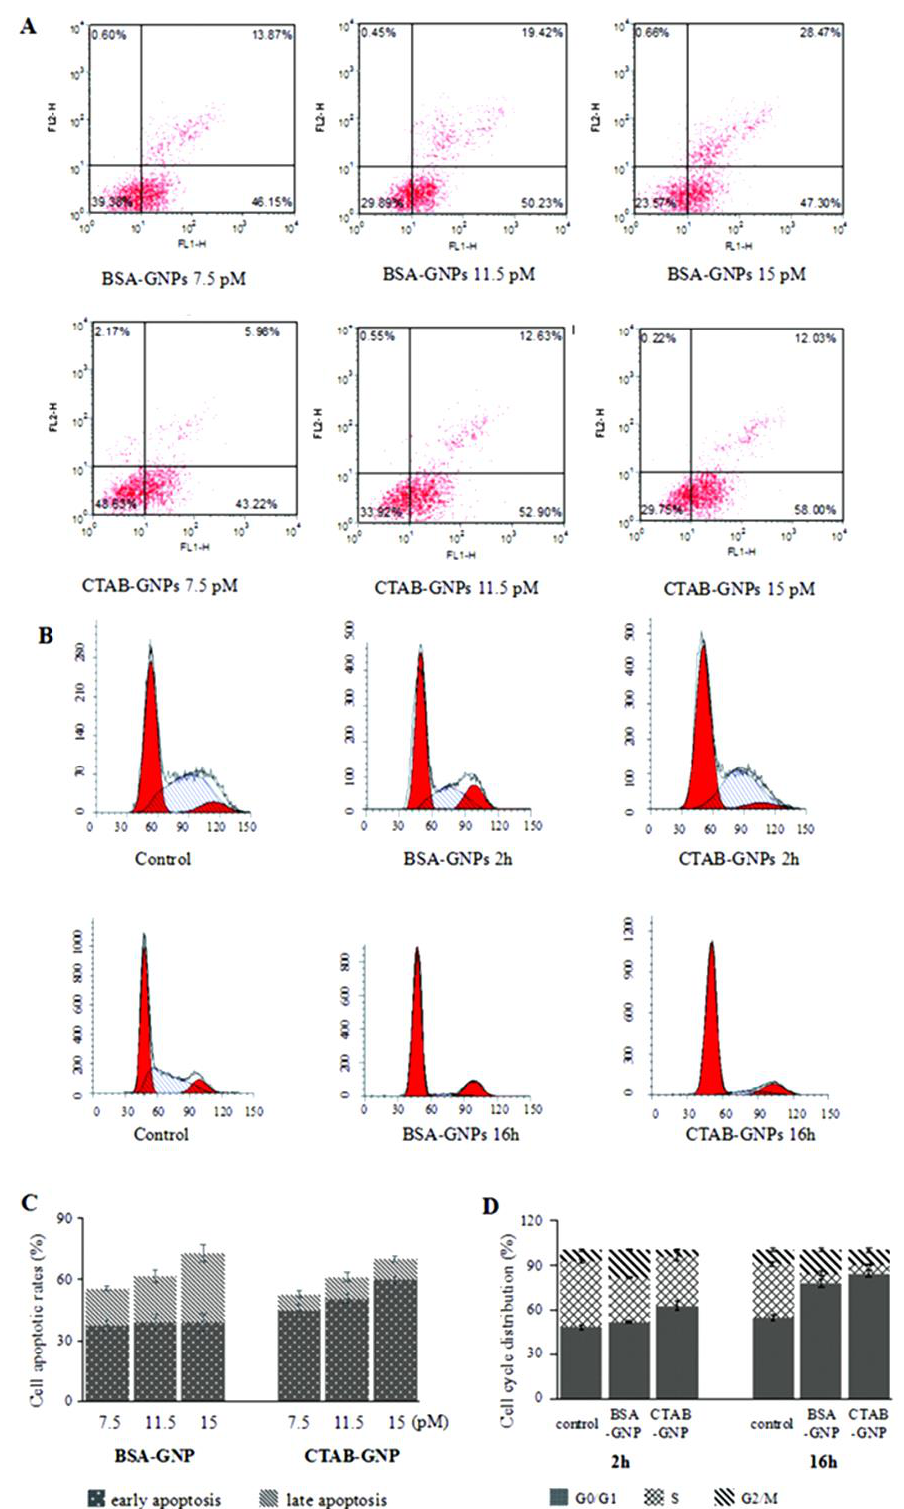
Figure 2. Apoptosis and cell cycle distributions of RAW264.7 cells before and after GNP treatment, with untreated cells used as control. ( A ) Flow cytometry images of GNPs inducing cell apoptosis after incubation for 16 h. ( B ) Flow cytometry images of cell cycle arrest in RAW264.7 cells treated with 15 pM BSA-GNPs and CTAB-GNPs for 2 or 16 h. ( C ) Barchart showing intensity of cell apoptosis. ( D ) Barchart showing distributions of the cell cycle.